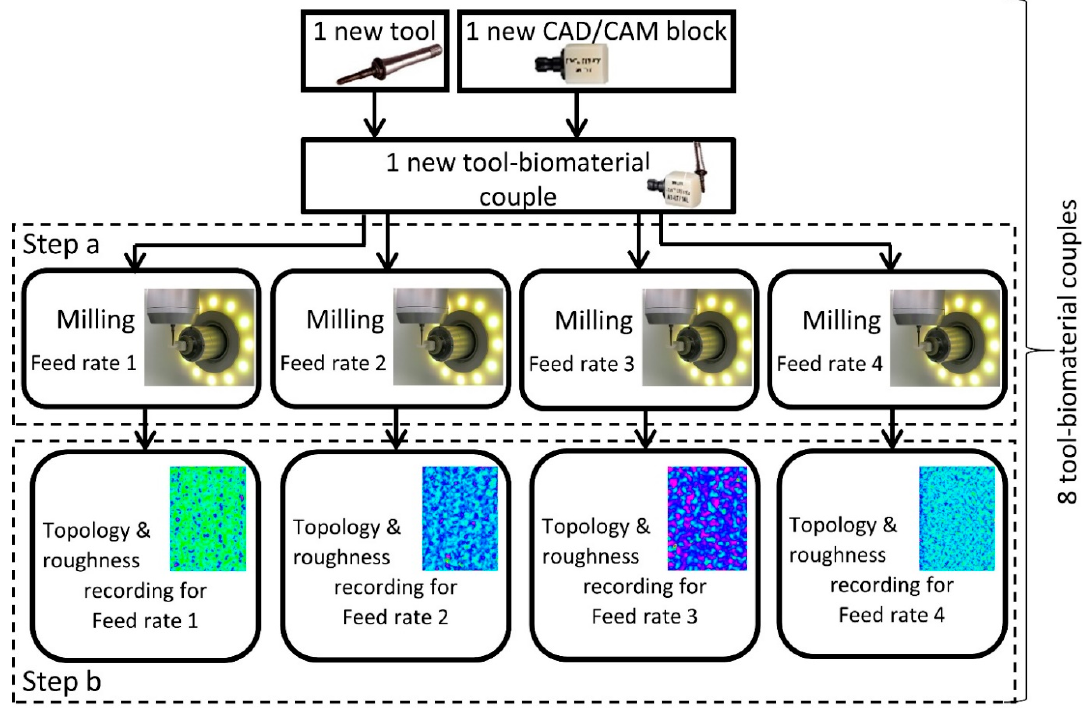
Figure 3. Diagram of experiment protocol.